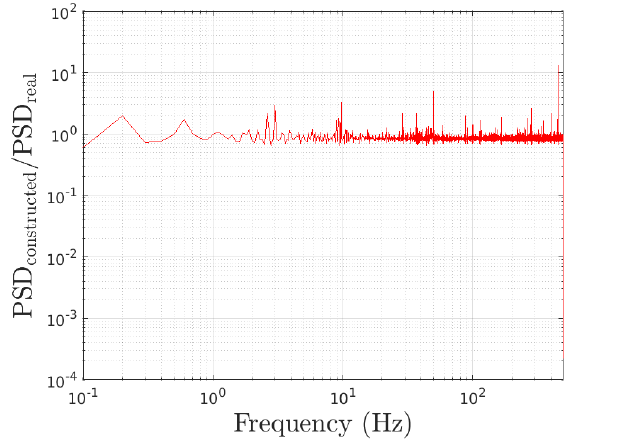
Figure 10. Ratio of the PSD from the expansion and the real PSD from accelerometer and velocimeter combined data. The ratio shows values that fluctuate around 1, implying the validity of the method.